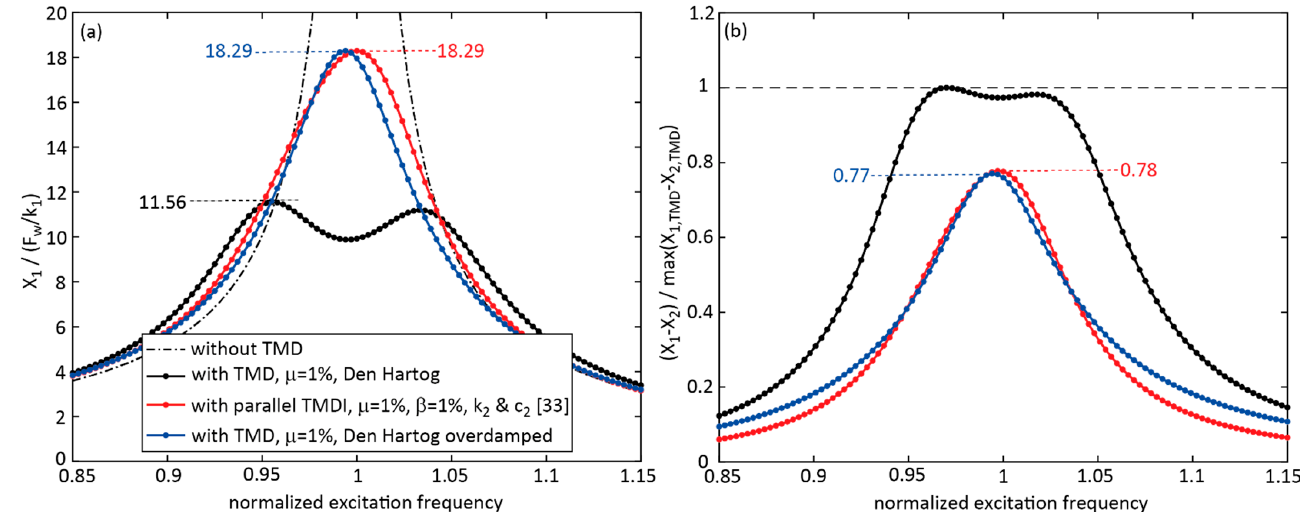
Figure 4. Performances of TMDI with inerter in parallel to stiffness and viscous damper ( µ = 1%, β = 1%, parameters as in [33]), TMD ( µ = 1%, Den Hartog parameters) and overdamped TMD ( µ = 1%) for harmonic excitation: ( a ) primary structure normalized displacement response and ( b ) normalized damper relative motion response.